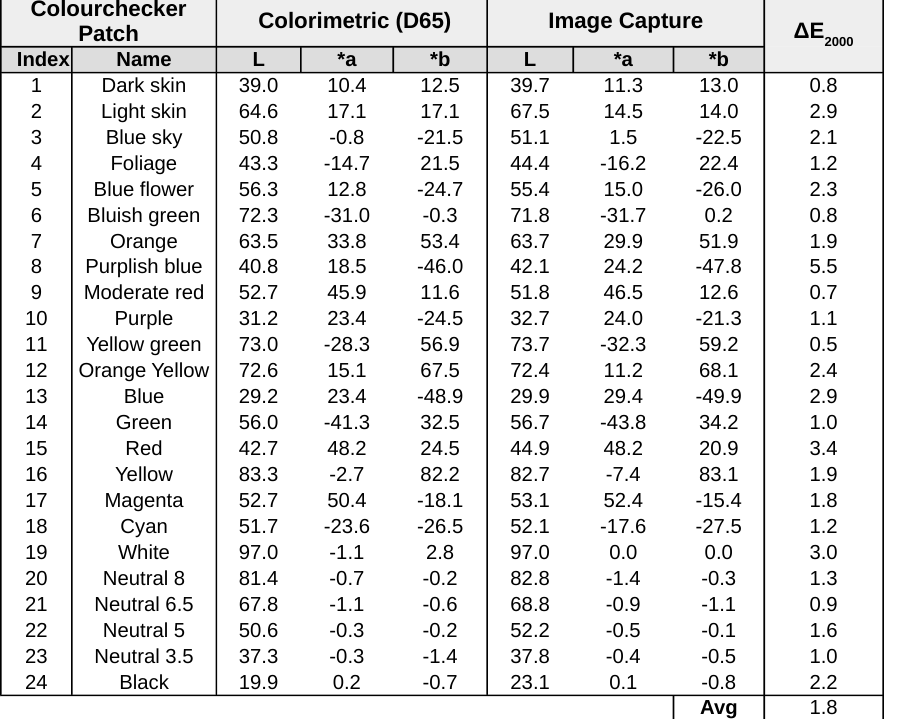
Table A2. Colour differences ∆ E between colour-calibrated image of Colourchecker patches and their colorimetric values to verify the image capture and colour calibration workflow.